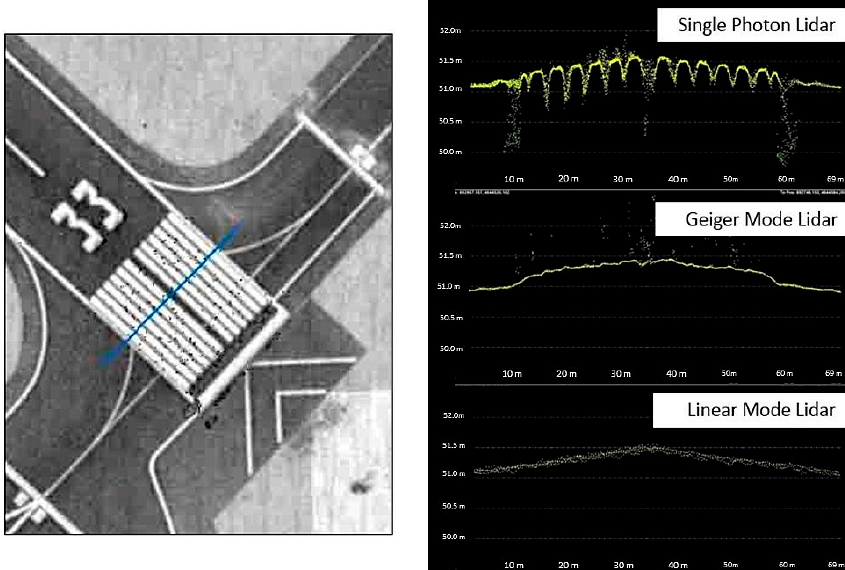
Figure 4. Example of range walk.